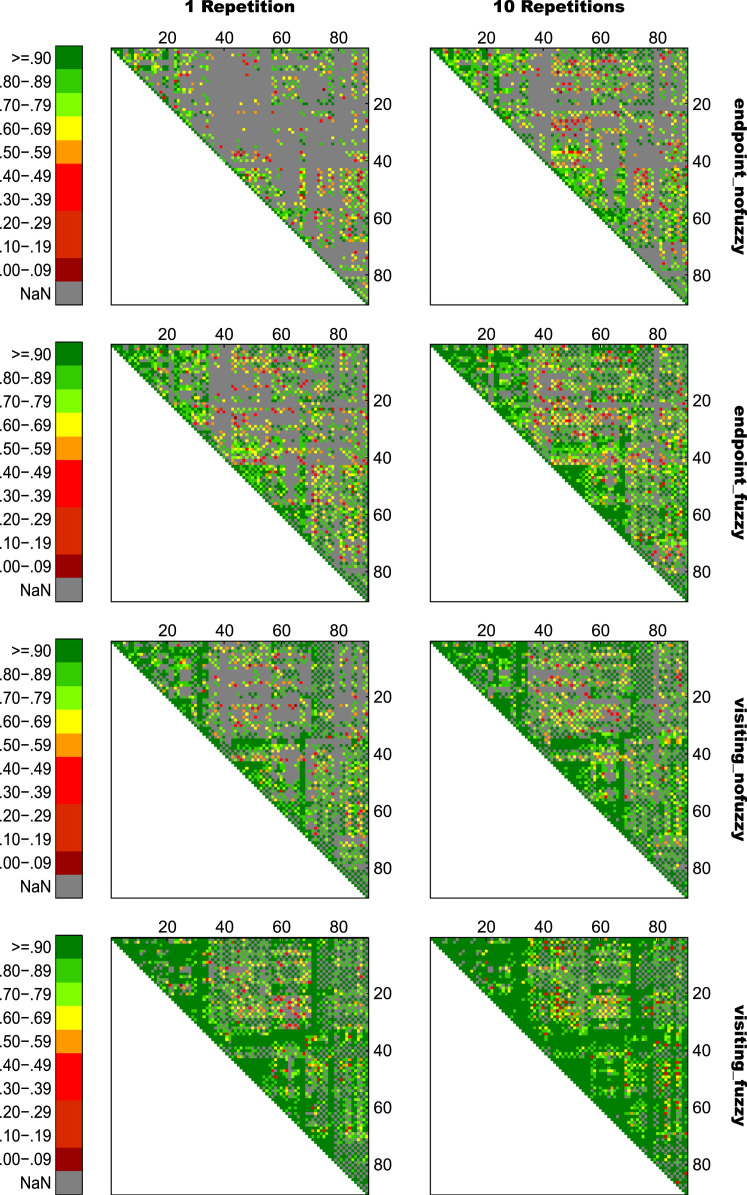
Seed-specific ICC(2,1) values for all connections of Model 1, estimating the within-session reproducibility of all eight variants of reconstruction repetitions×streamline selection variant. Numbers on the x- and y-axis refer to AAL seed numbers. For visualization purposes, negative ICC(2,1) values were set to zero (0.02% of values).